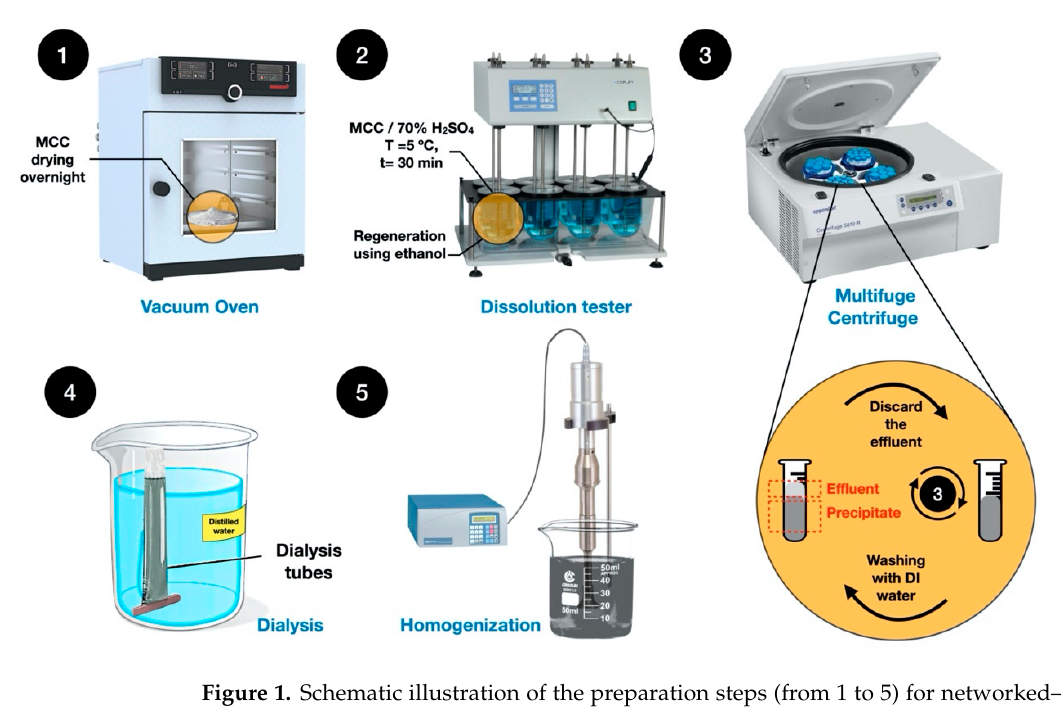
Figure 1. Schematic illustration of the preparation steps (from 1 to 5) for networked–nanofibrous cellulose